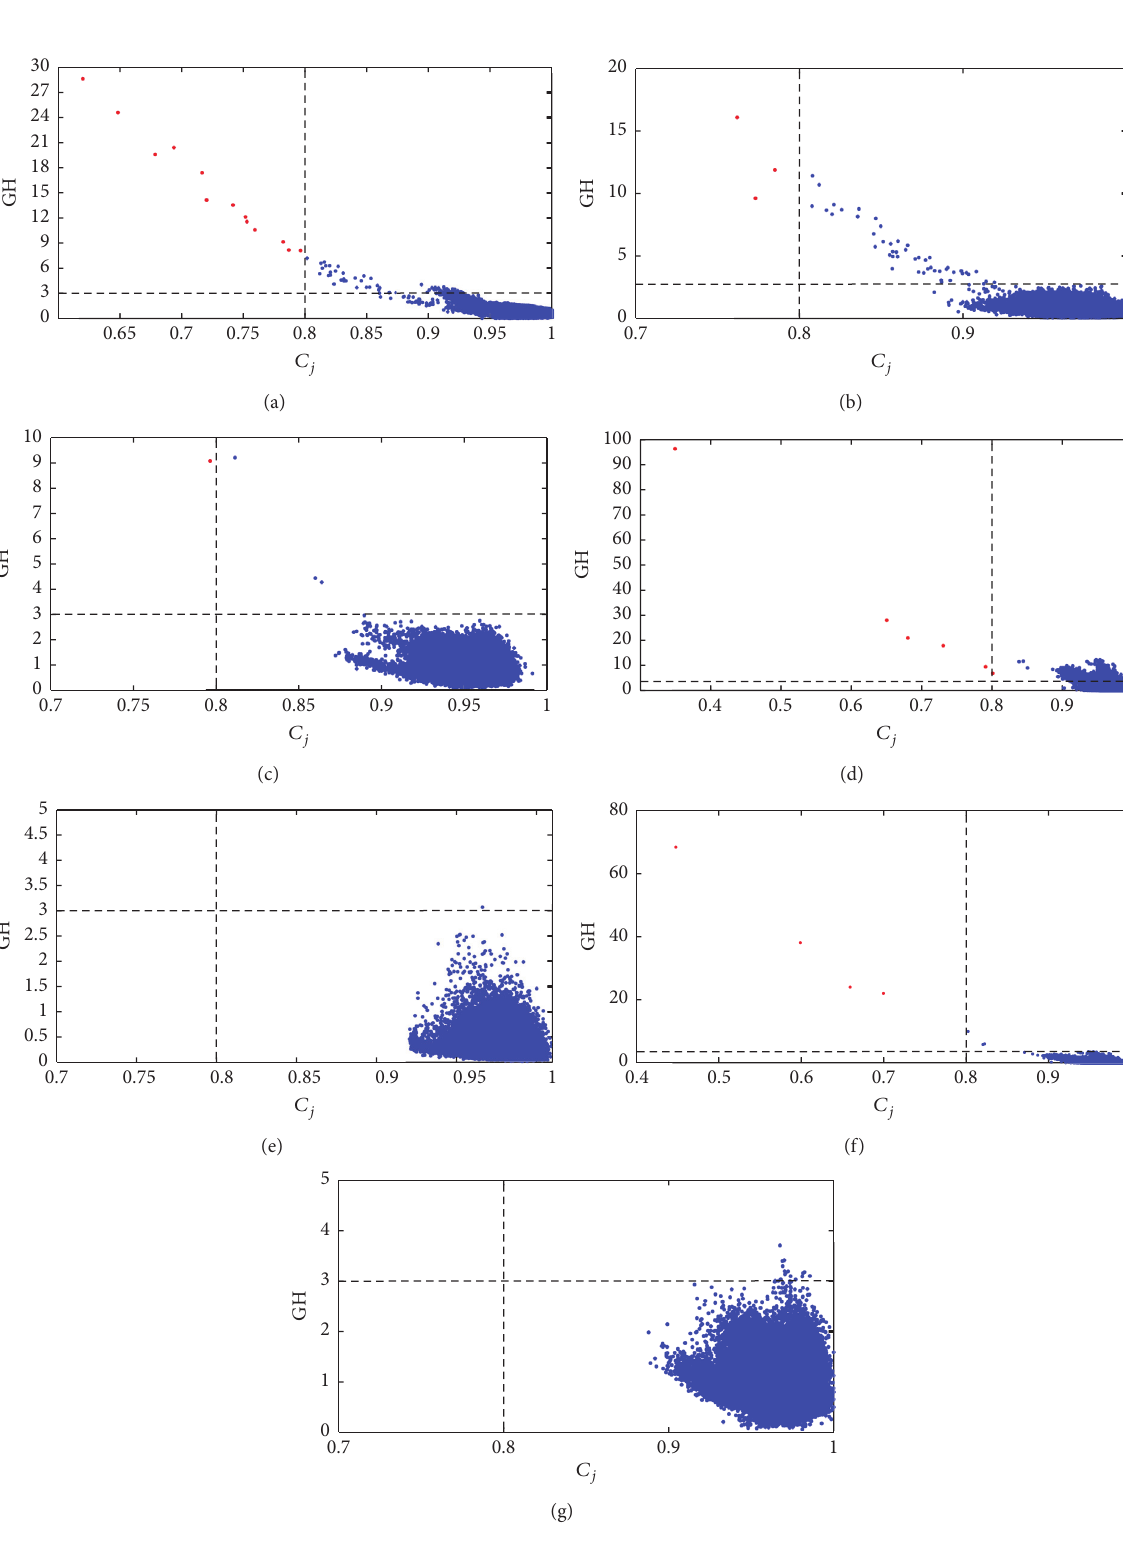
Figure 6: The 𝐶 𝑗 -GH diagram of Set C. (a), (b), and (c) represent 1000, 500, and 100 mgkg −1 of melamine images, while (d), (e), (f), and (g) represent four 50 mg kg −1 of melamine